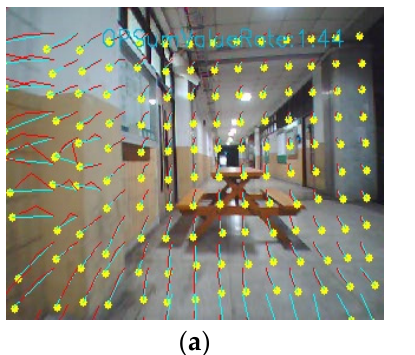
Figure 5. Using the length of optical flow to determine feasible flight space. ( a ) Optical flow (the yellow dots denote the tracked points, and the red and cyan trajectories are the optical flow vectors); ( b ) feasible flight space (the blue region).